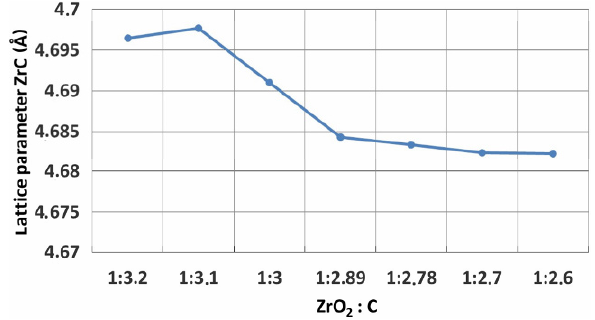
Fig. 5 Lattice distance of ZrC in relation to ZrO 2 :C